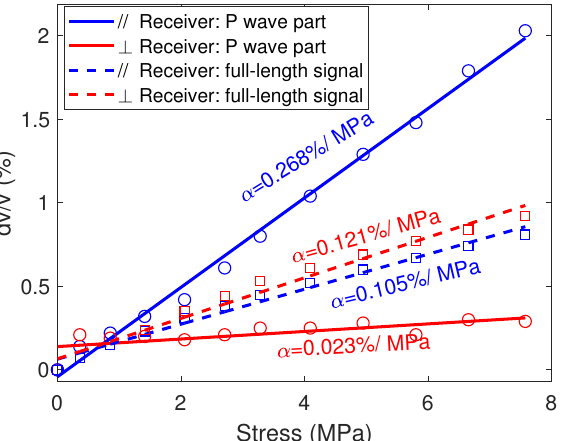
Figure 13. Relative velocity change vs. stress by applying stretching technique to the P wave part and full-length signals in parallel and transverse directions.